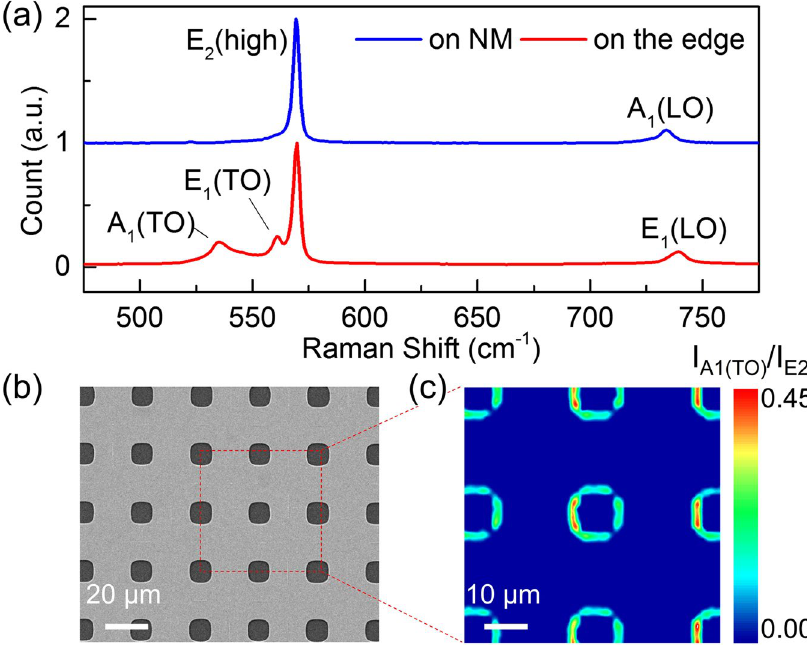
Figure 3. ( a ) The Raman spectrum of DH NM with the exciting laser spot on the NM and on the edge of NM. ( b ) SEM image of an N-polar NM with diagonal via spacing of 25 µ m ( c ) Spatial mapping of intensity ratio of the A 1 (TO) to E 2 (high) peak. The scanning area is 60 × 60 µ m 2 , indicated by red square in ( b